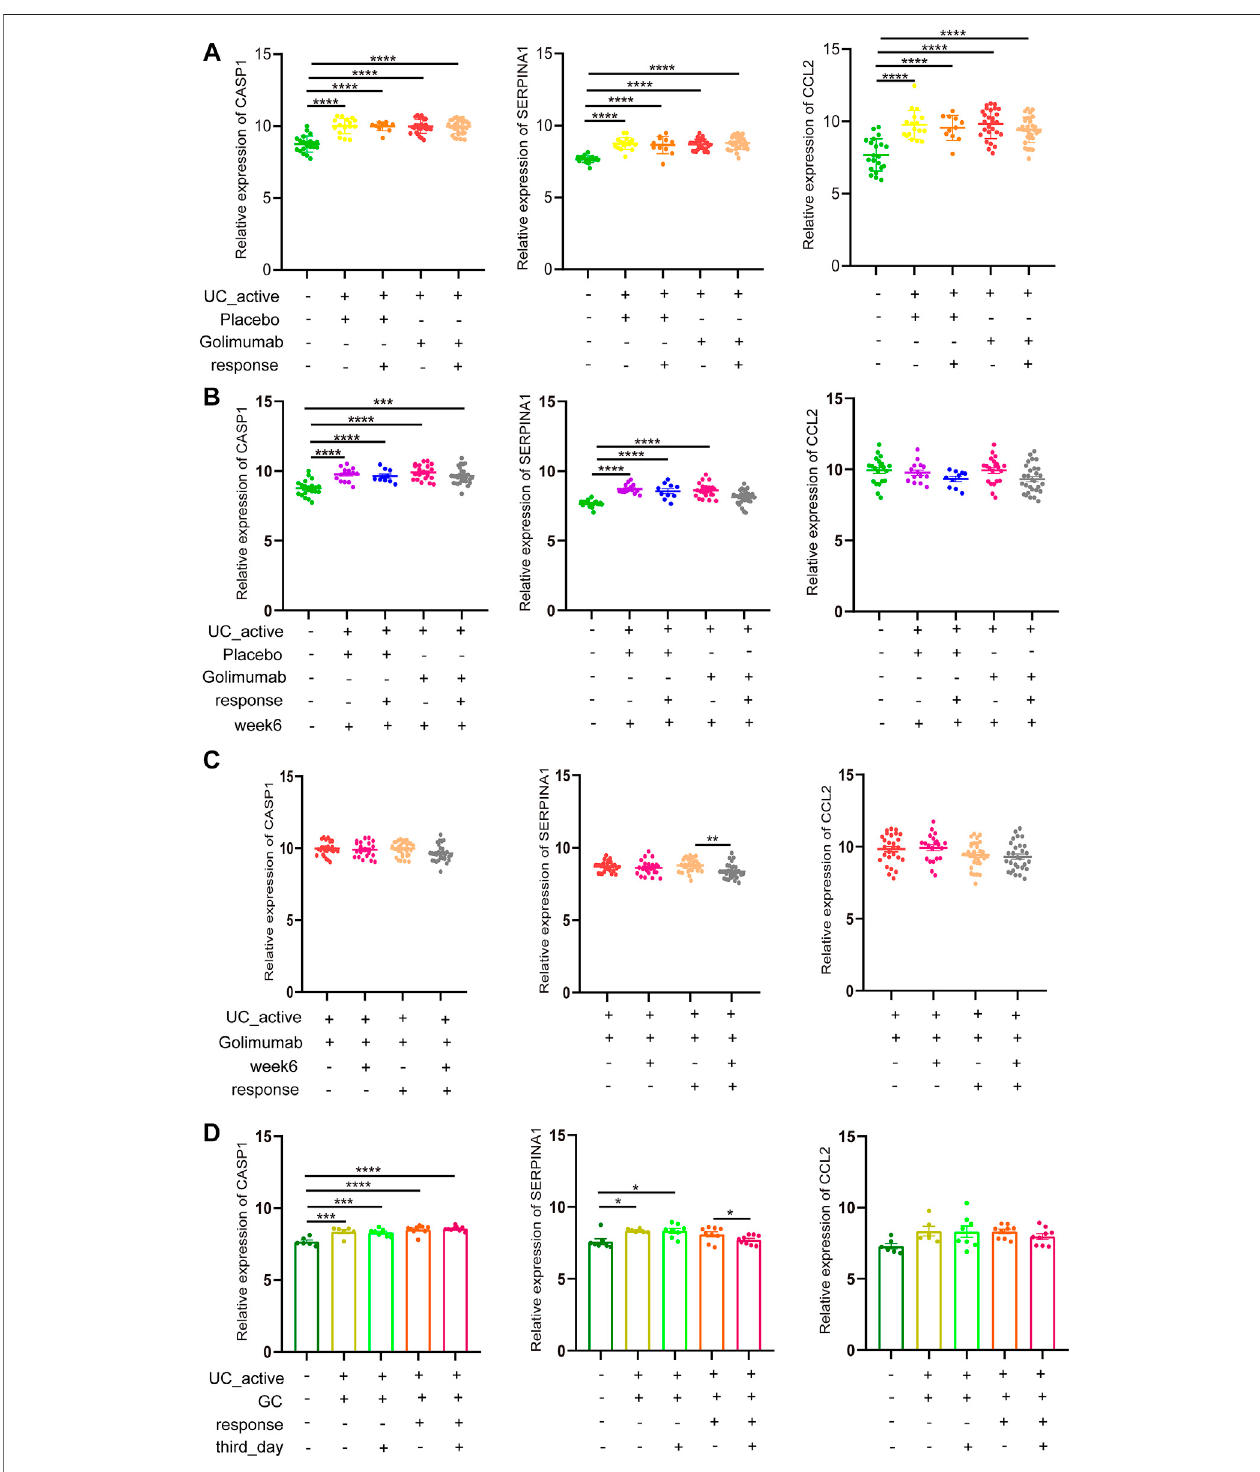
FIGURE 6 | GC or golimumab responders improve impaired autophagy of intestinal mucosal in patients with active UC by reducing SERPINA1. (A) The relative expression levels of CASP1, SERPINA1, and CCL2 in the intestinal mucosa of active UC patients in responding and non-responding groups before golimumab treatment. (B) The relative expression levels of CASP1, SERPINA1, and CCL2 in the intestinal mucosa of active UC patients in responding and non-responding groups after 6 weeks of golimumab treatment. (C) The relative expression levels of CASP1, SERPINA1, and CCL2 in the intestinal mucosa of active UC patients in responding and non-responding groups before and after 6 weeks of golimumab treatment. (D) The relative expression levels of CASP1, SERPINA1, and CCL2 in the intestinal mucosa of active UC patients in responding and non-responding groups before and after GC treatment for 3 days. UC, ulcerative colitis. GC, glucocorticoid. * p < 0.05, ** p < 0.01, *** p < 0.001, **** p < 0.0001.